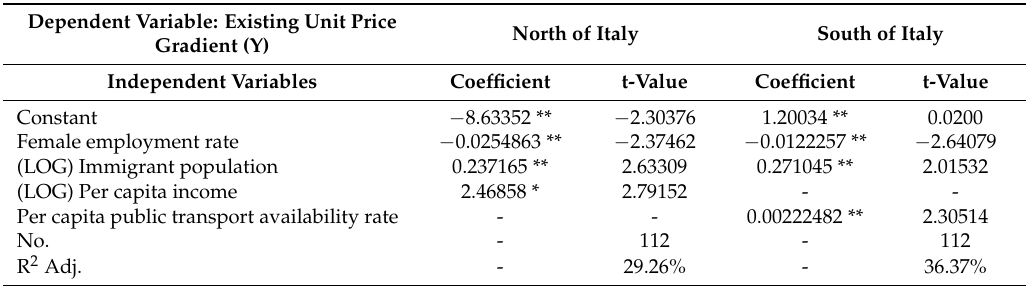
Table 5. Estimation of the housing price gradient for existing housing units in northern versus southern Italy.